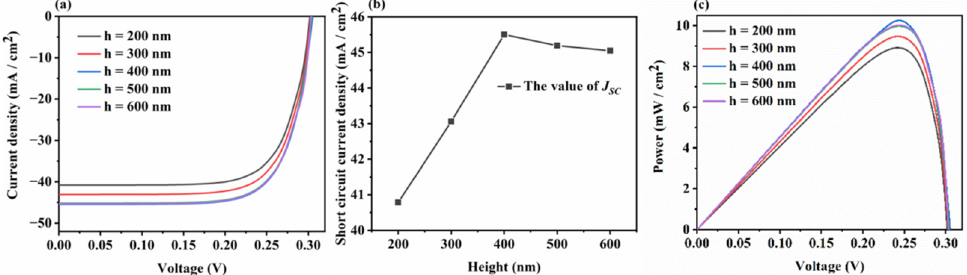
Figure 3. ( a ) Current density curves at different cross ‐ cone heights. ( b ) The effect of cross ‐ cone heights on J SC . ( c ) Output power curves at different cross ‐ cone heights.